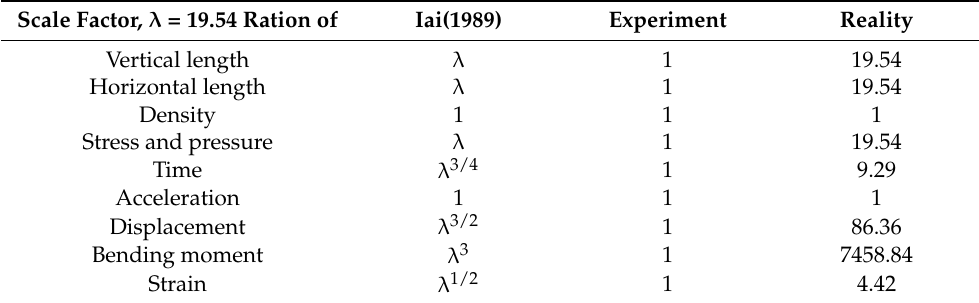
Table 1. Generalized scaling law for model